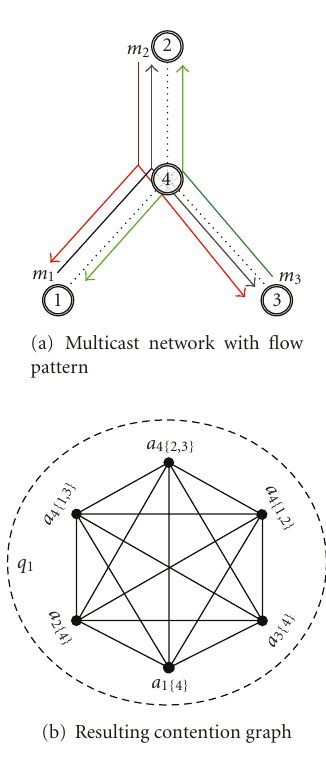
Figure 4: E ff ect of time-varying wireless channel.